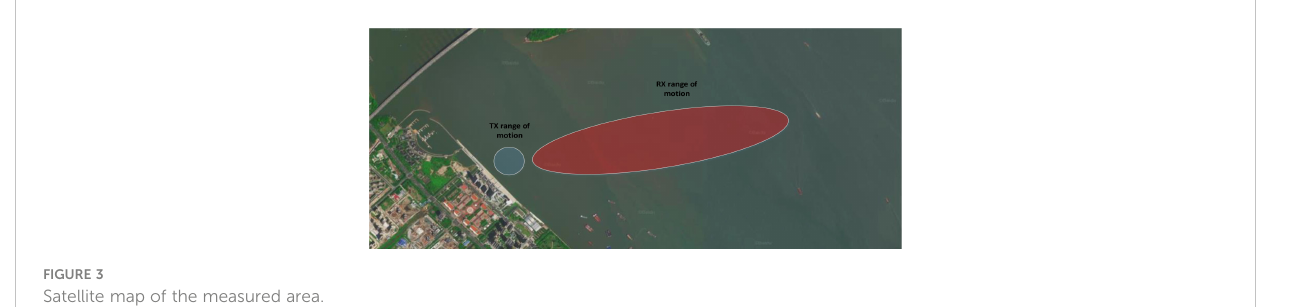
FIGURE 3 Satellite map of the measured